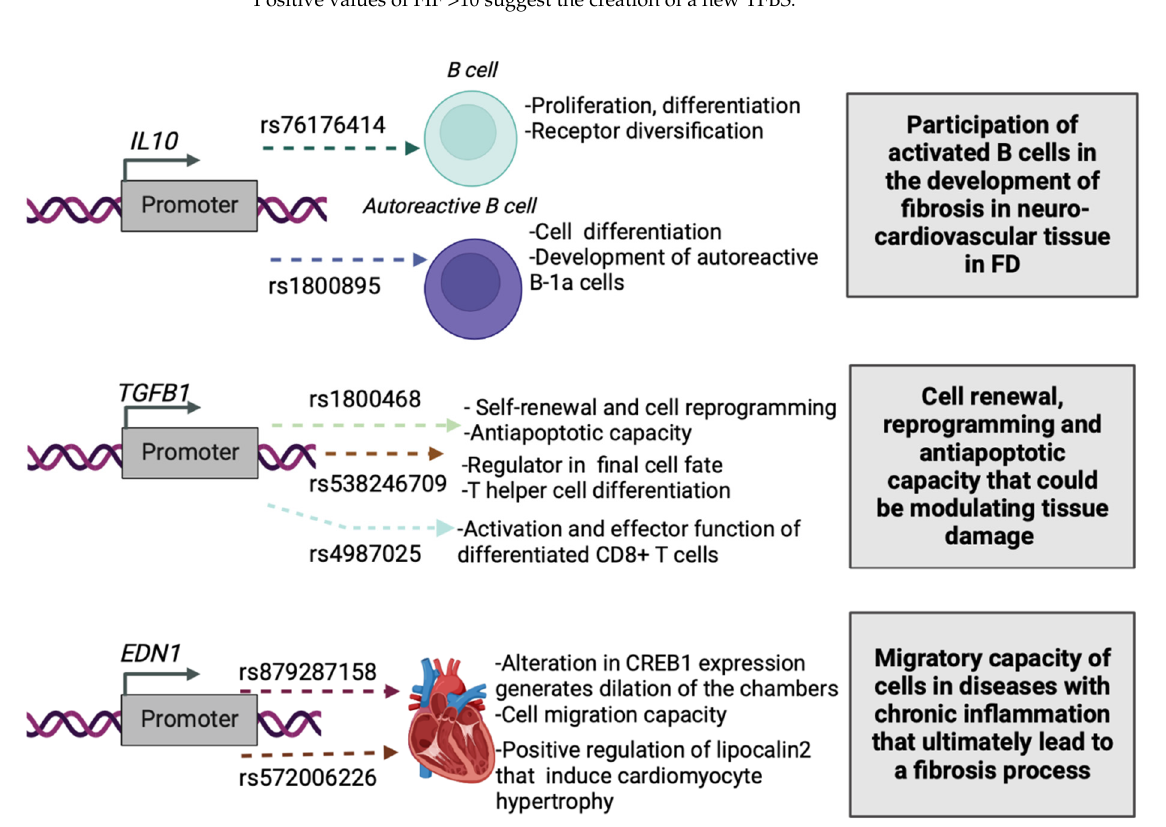
Figure 1. Proposed impact of the SNPClinic-predicted rSNPs in FD (“ALL” population from 1000 Genomes Project). Figure was designed in Biorender (https://biorender.com/, accessed on 15 March